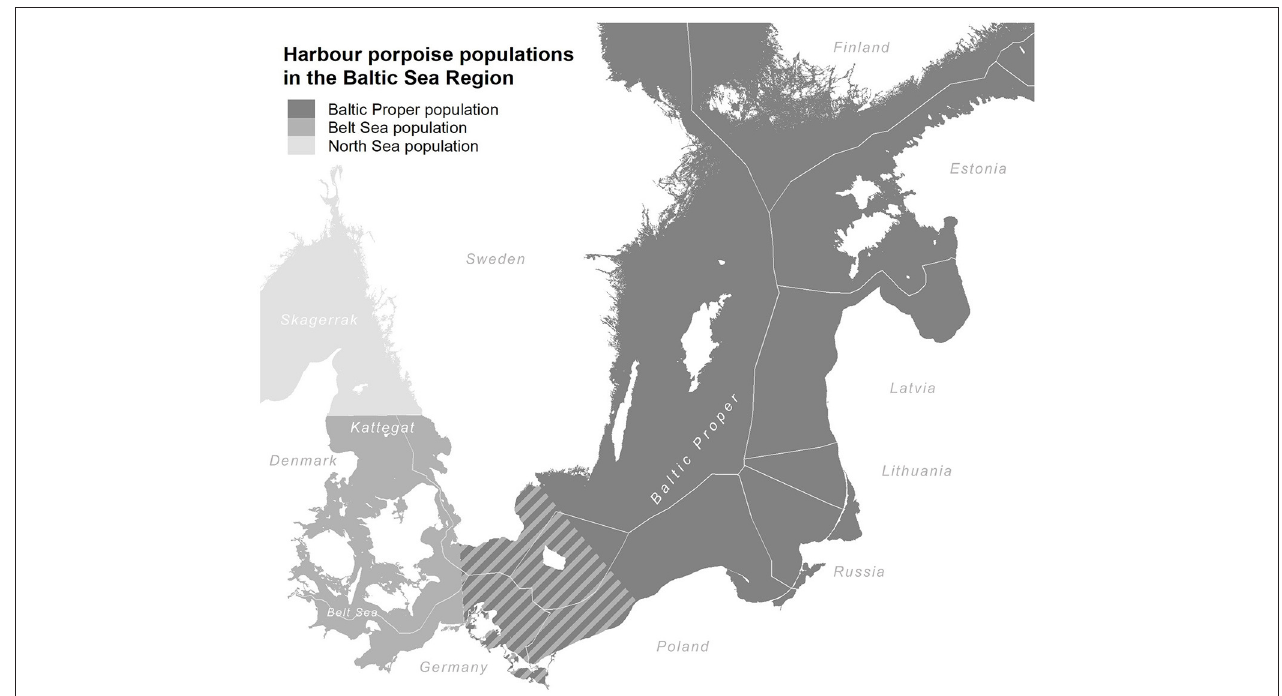
FIGURE 2 | Map showing the approximate distributions of harbor porpoise populations in the Baltic Sea Region (after Sveegaard et al., 2015; Carlén et al.,